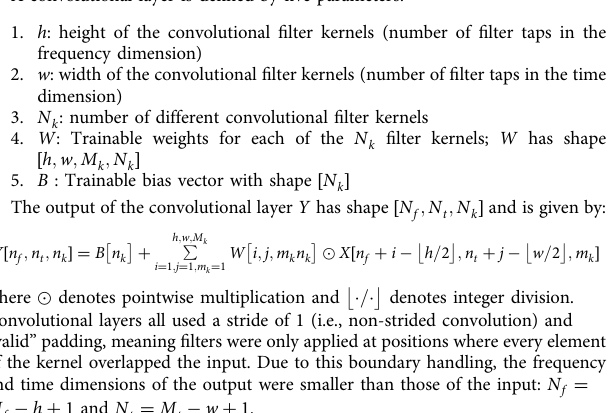
1. h : height of the convolutional fi lter kernels (number of fi lter taps in the frequency dimension) 2. w : width of the convolutional fi lter kernels (number of fi lter taps in the time